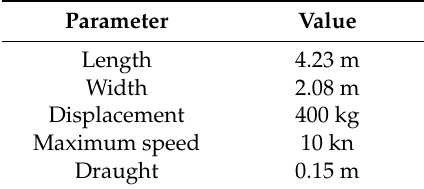
Table 1. Specifications of the